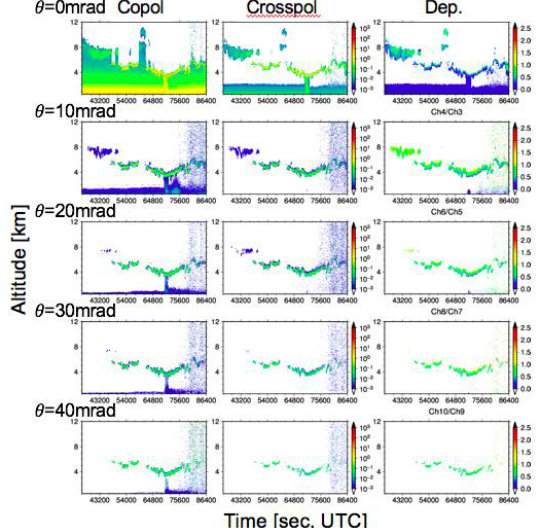
Fig. 2 Time-height cross sections of copol and crosspol components of the attenuated backscatter coefficients [/m/sr] and depolarization ratio for on-beam (  =0mrad) and off-beam (  =10, 20, 30, and 40 mrad) signals observed at Koganei, Tokyo, Japan on June 27,